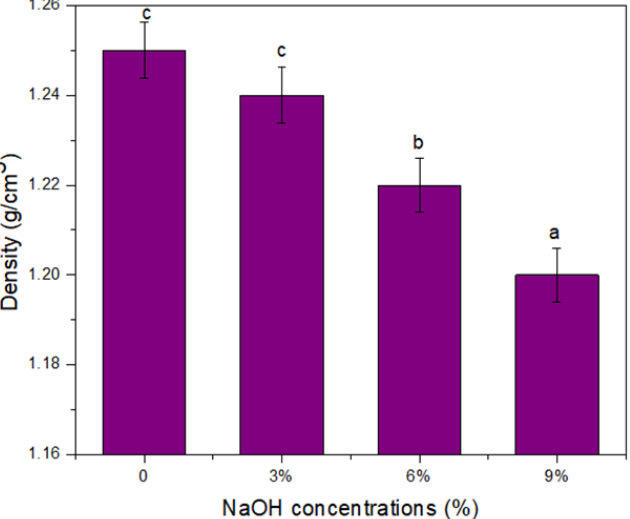
Figure 8. Density of untreated and treated TPCS/PW/CCF composites. Letters a, b, and c is indicates the group of data for statistical analysis.